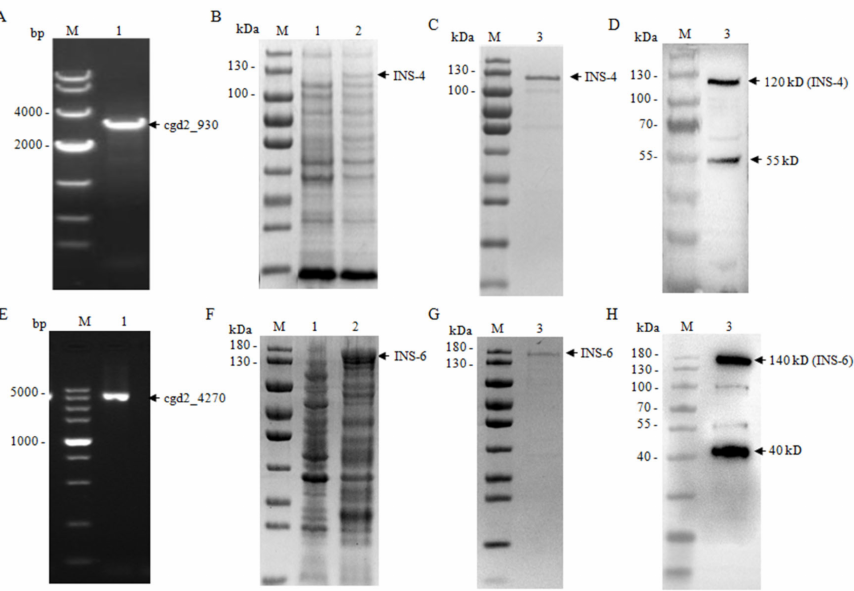
Figure 2. Expression of recombinant CpINS-4 and CpINS-6 in Escherichia coli. ( A – D ) Expression of CpINS-4 in E. coli BL21 (DE3). The cgd2_930 gene encoding CpINS-4 of C. parvum was amplified